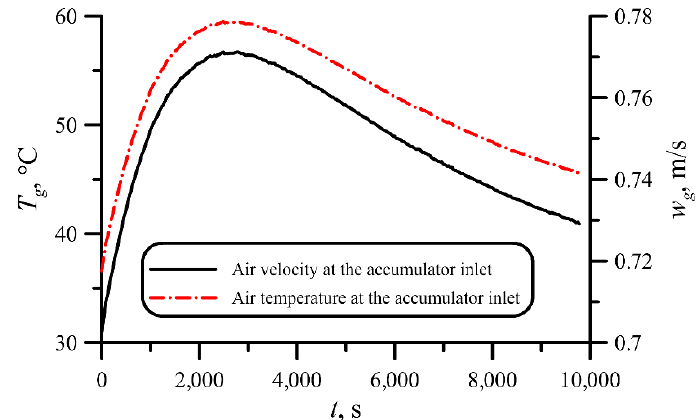
Figure 11. Time changes of air velocity and temperature at the accumulator inlet.